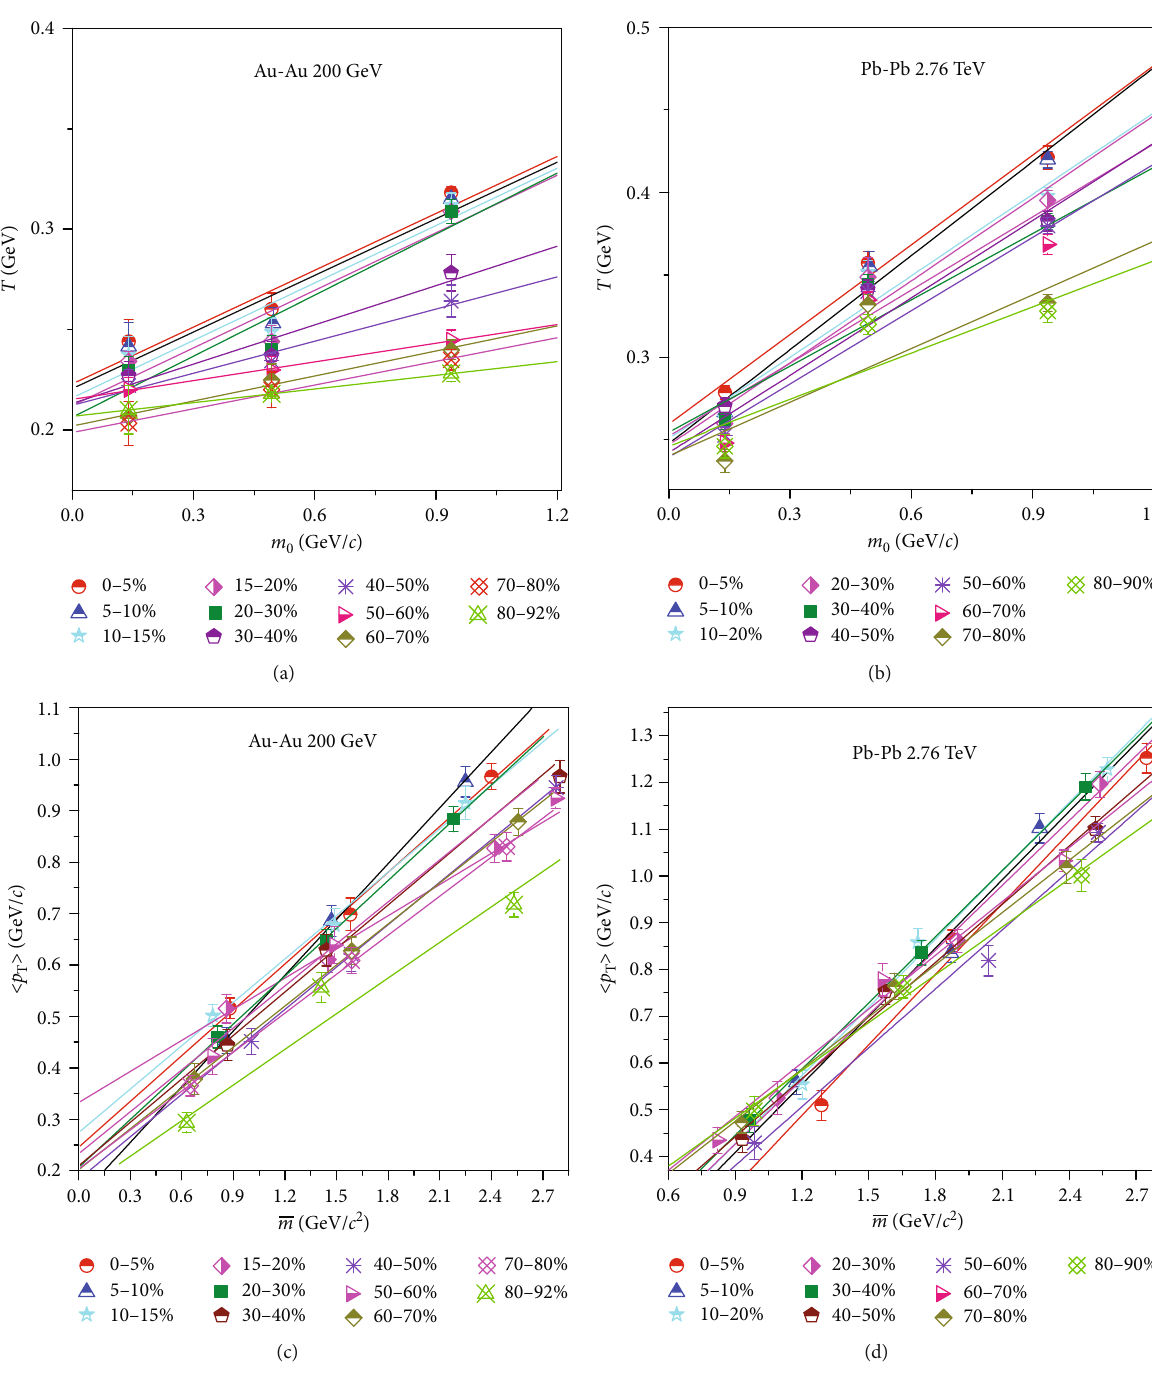
Figure 7: Dependence of (a, b) e ff ective temperature T on the rest mass m or mean moving mass (cid:1) m for (a, c) Au-Au collisions at 200 GeV and (b, d) Pb-Pb collisions at 2.76TeV in di ff erent centrality classes. The lines are the results fi tted for the values of derived